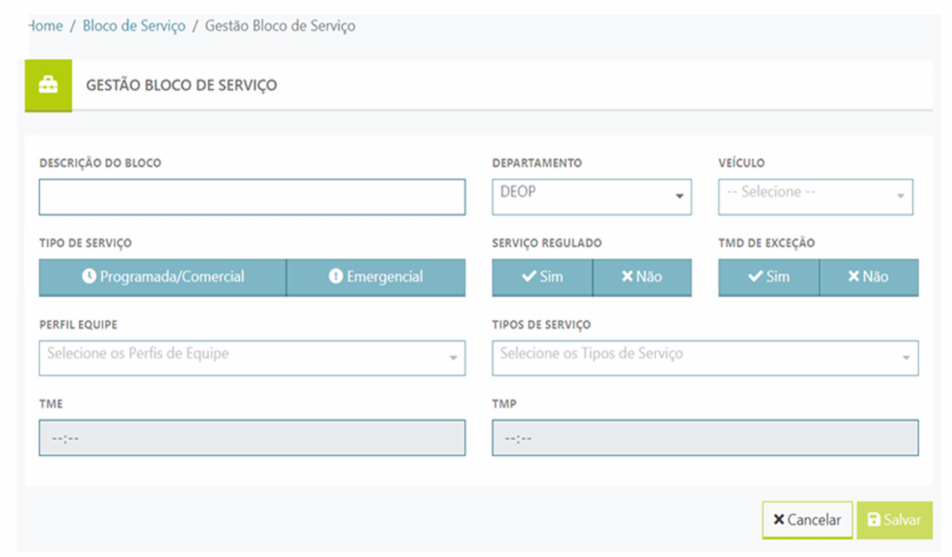
Figure 3. Inside look of each Service Block. The user interface (UI) is in Portuguese because this system is already in use by the energy utility. The terms represent service type description (descriç ã o do bloco), department (departamento), vehicle (ve í culo), service type (tipo de serviço), planned or commercial (programada/commercial), emergency (emergencial), regulated service (serviço regulado), yes (sim), no (n ã o), special travel time (TMD de exceç ã o), team skill (perfil equipe), execution time (TME) and preparation time